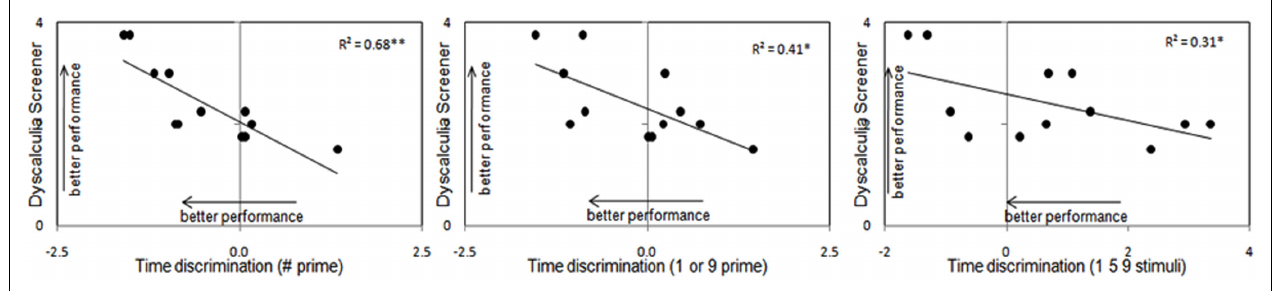
FIGURE 4 | Correlations between the degree of dyscalculia expressed by the Dyscalculia Screener (Butterworth, 2003) and proficiency in time discrimination in all the experimental conditions in dyscalculic participants